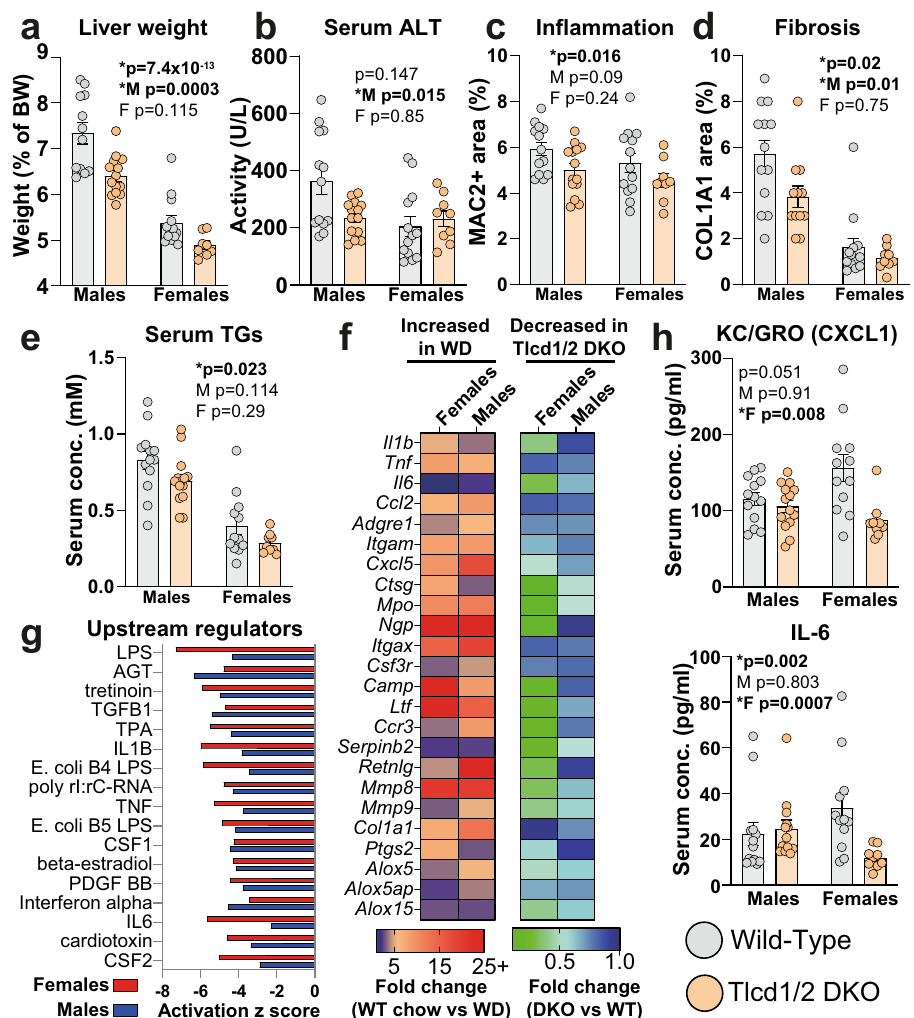
Fig. 4 | Tlcd1/2 de fi ciency reduces the severity ofNASH in WD-fed mice. a Liver